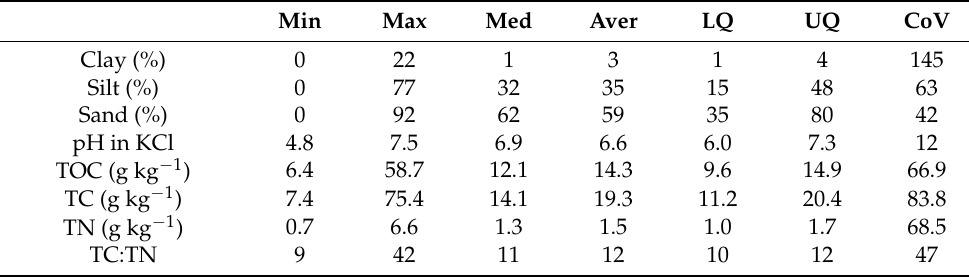
Table 1. Physicochemical properties of soils (n = 30).